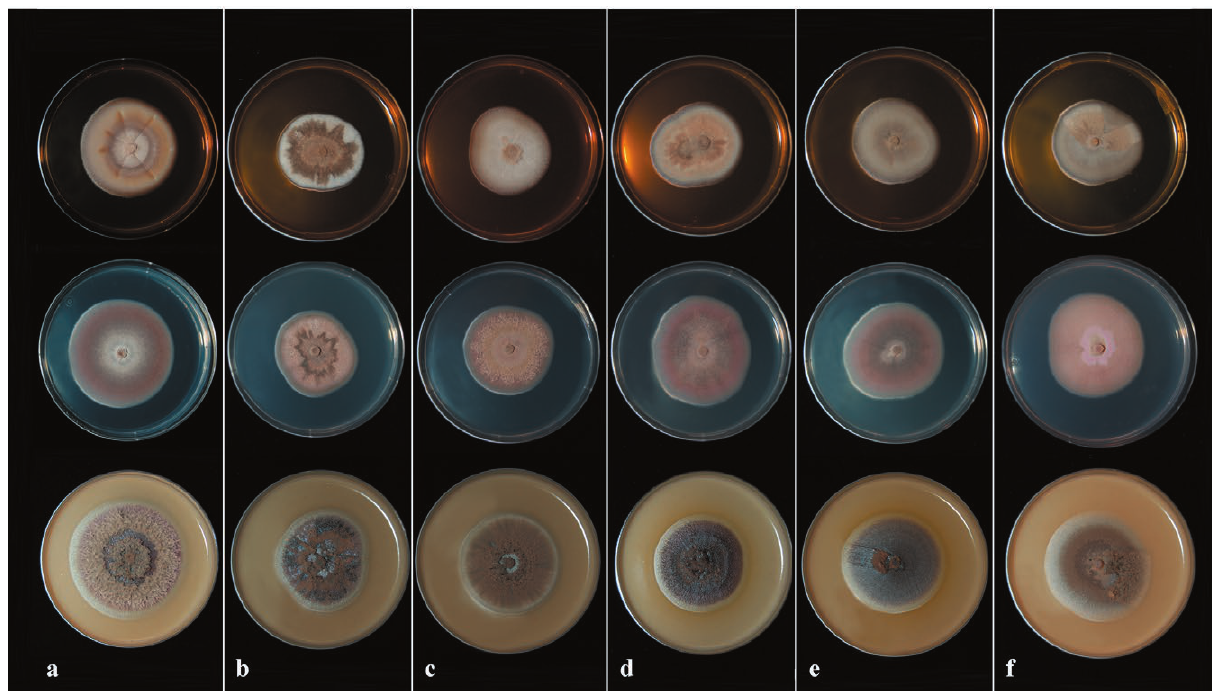
Figure 4. Representative culture morphologies for Phaeoacremonium italicum . The cultures were grown at 25°C on malt extract agar (top row), potato dextrose agar (middle) and oatmeal agar (bottom row) for 21 d. ( a ) CBS 137763 strain, representing sub-group #1; ( b ) Pm31 strain, sub- group #2; ( c ) Pm50M strain, sub-group #3; ( d ) Pm45 strain, sub-group #4; ( e ) Pm17 strain, sub-group #5; ( f ) Pm59 strain, sub-group